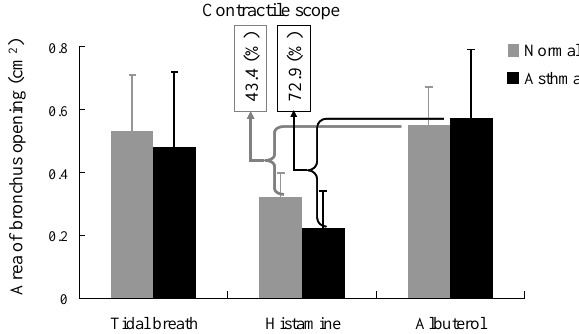
Fig. 8. Comparison of the areas of bronchus opening for either normal or asthmatic subjects in the absence or presence of histamine/albuterol challenge. The results for the normal, asthmatic subjects are presented as gray, black bars, and as mean (cid:2) SD, respectively. Histamine and Albuterol represent the opening areas of the bronchus that was either maximally con- tracted (5 min post inhalation of histamine at 8 mg/ml) or maximally relaxed (5 min post inhalation of albuterol at 2.5 mg/ml for 30 s). Contractile scope indicates the di®erence of bronchus opening between the maximally relaxed (Albuterol) and maximally contracted (Histamine) conditions as percen- tage of the area of bronchus opening during tidal